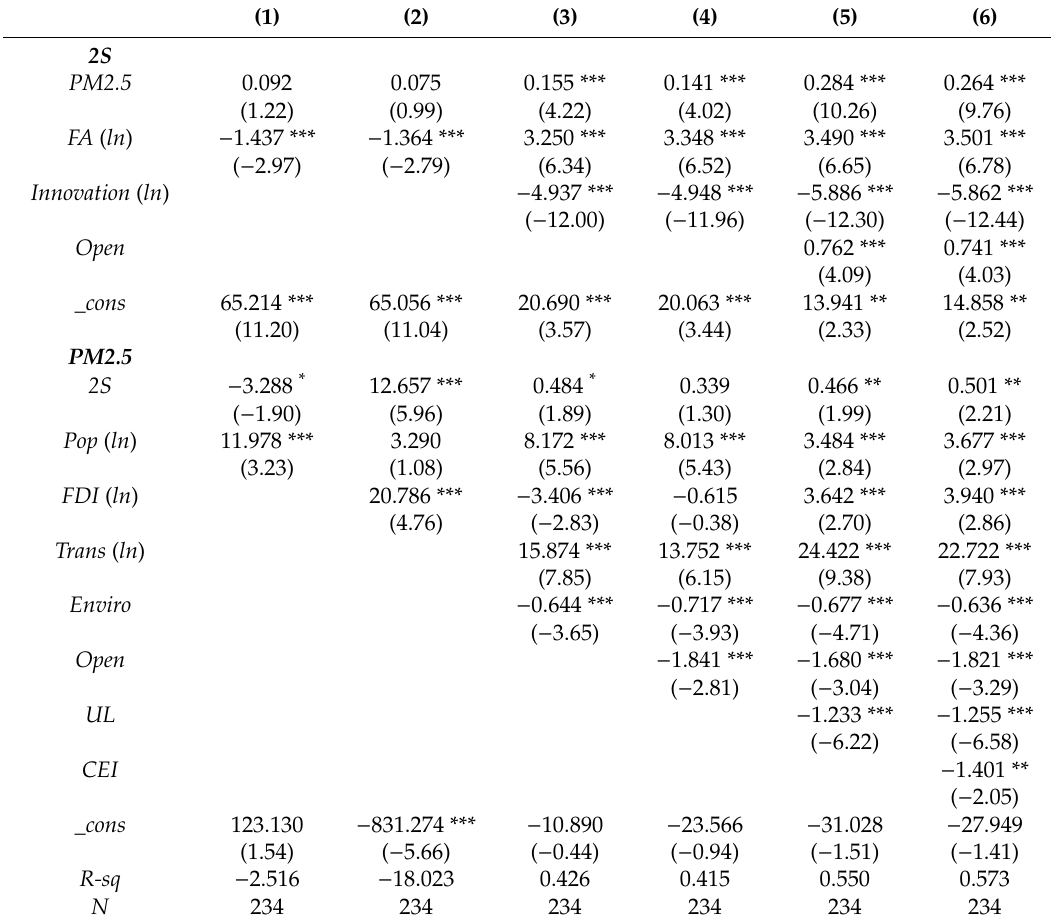
Table 4. Estimated results of the simultaneous equations for secondary industry and air